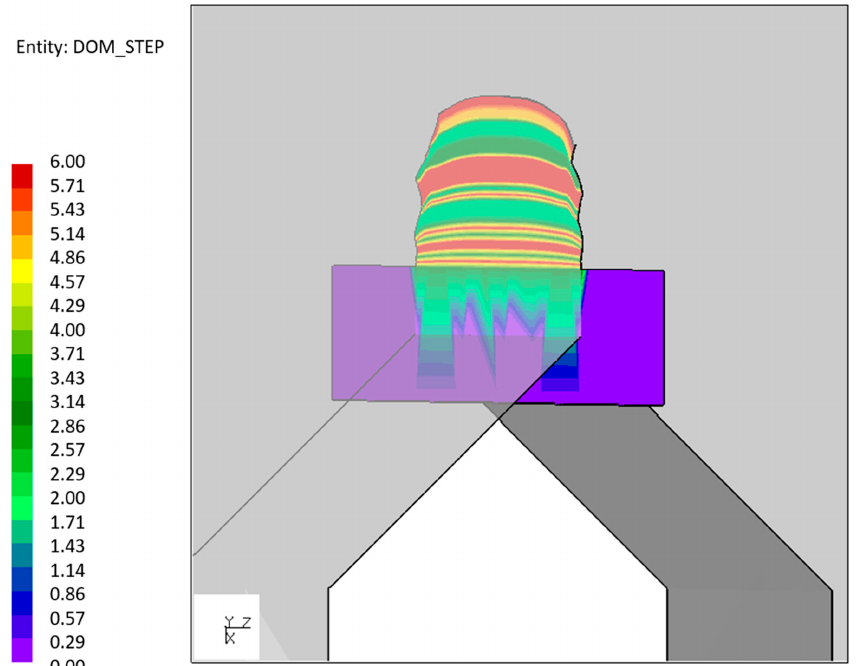
Figure 17. Dominant step distribution over the specimen 0_1_90_3 numerical crack surface.